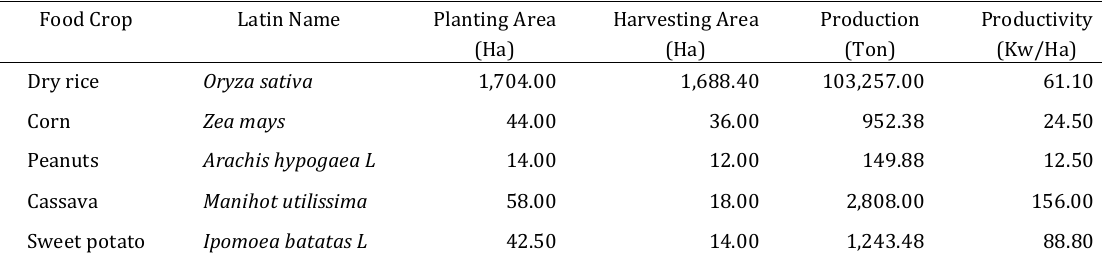
Table 2 Planting Area, Harvest, Production and Food Crop